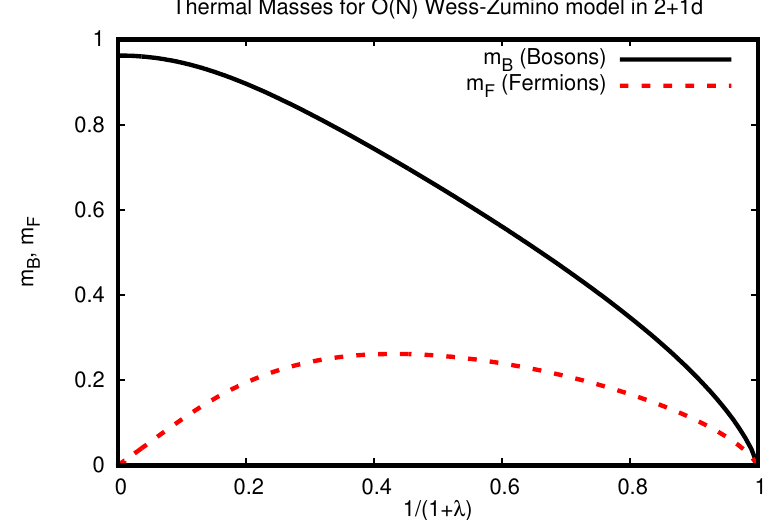
Figure 1 . Thermal masses (divided by temperature) in the O(N) Wess-Zumino model in 2+1d in the large N limit for all coupling values. Horizontal axis has been compacti(cid:12)ed in order to show the full range (cid:21) 2 [0 ; 1 ). See text for